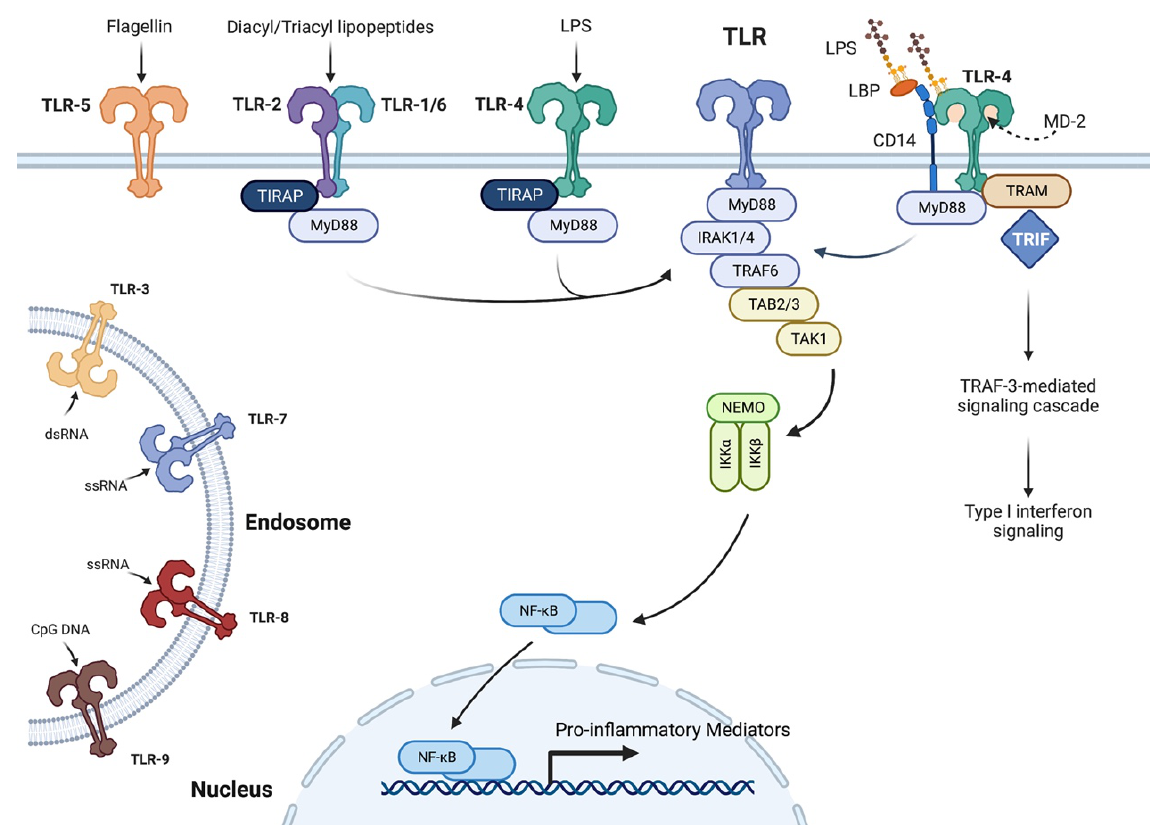
Figure 2. Toll-like Receptor Signaling Pathway. Toll-like receptors are located in the plasma membrane (TLR-2/-1, TLR-2/-6, TLR-4 and TLR-5) or the endosome (TLR-3, TLR-7, TLR-8 and TLR-9) where they are engaged by the indicated microbial components to initiate signaling through myeloid differentiation primary response 88 (MyD88) and in some cases the adaptor TIR domain-containing adaptor protein (TIRAP). MyD88 interaction with interleukin-1 receptor-associated kinase (IRAK) protein kinases activates TNF receptor-associated factor-6 (TRAF6) and through the adaptors TAB2 and 3, the kinase (TGF β )-activated kinase 1 (TAK1). TAK1 phosphorylates and activates inhibitory kappaB (I κ B) kinases (IKK)- α and - β , which are in complex with a regulatory subunit, NF κ B essential modulator (NEMO), also known as IKK γ . Phosphorylation of I κ B targets it for degradation thereby releasing the transcription factor, nuclear factor kappa-light-chain-enhancer of activated B cells (NF κ B). NF κ B translocates into the nucleus where it promotes the expression of pro-inflammatory mediators. TLR-4 signaling also involves lipopolysaccharide (LPS)-binding protein (LBP), which helps to present LPS to the TLR-4 receptor complex, which also includes myeloid differentiation protein-2 (MD-2) and the co-receptor cluster of differentiation-14 (CD-14). LPS binding to TLR-4 can also activate a MyD88-independent pathway through TIR domain-containing adaptor inducing interferon- β (TRIF) and translocation-associated membrane protein (TRAM) to activate TRAF3 to induce type I interferon expression; dsRNA = double-stranded RNA, ssRNA = single-stranded RNA and CpG DNA = CpG-rich DNA. Created with